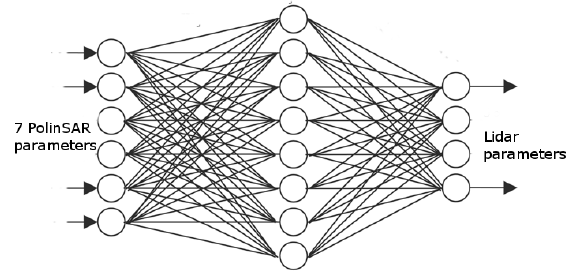
Figure 13. Principle of the fusion with a perceptron